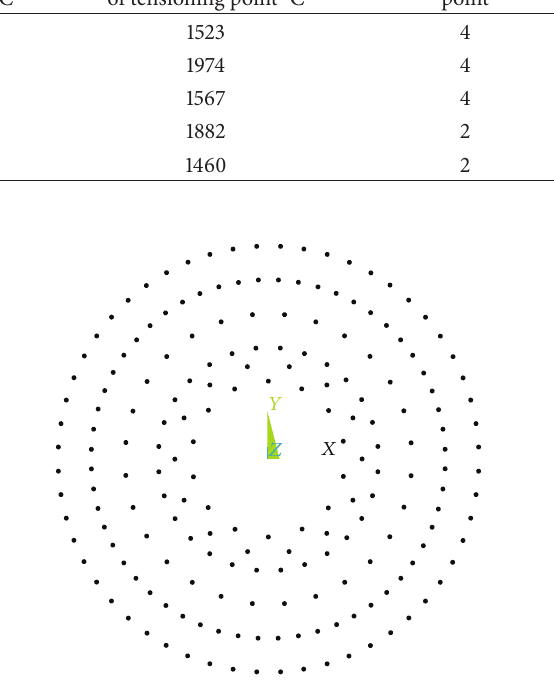
Figure 3: Layout of temporary